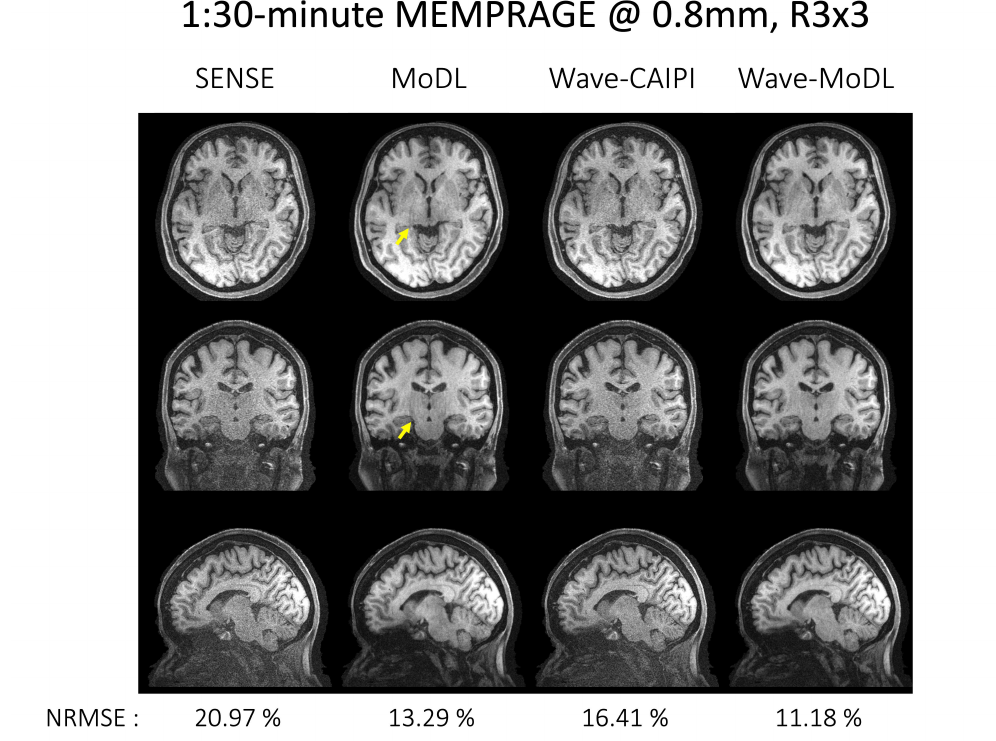
Figure 4. The proposed method on the MEMPRAGE database at R = 3 × 3-fold and 0.8 mm isotropic voxel resolution. Echo images were combined by calculating the root mean squared image. NRMSEs were calculated for the entire testing